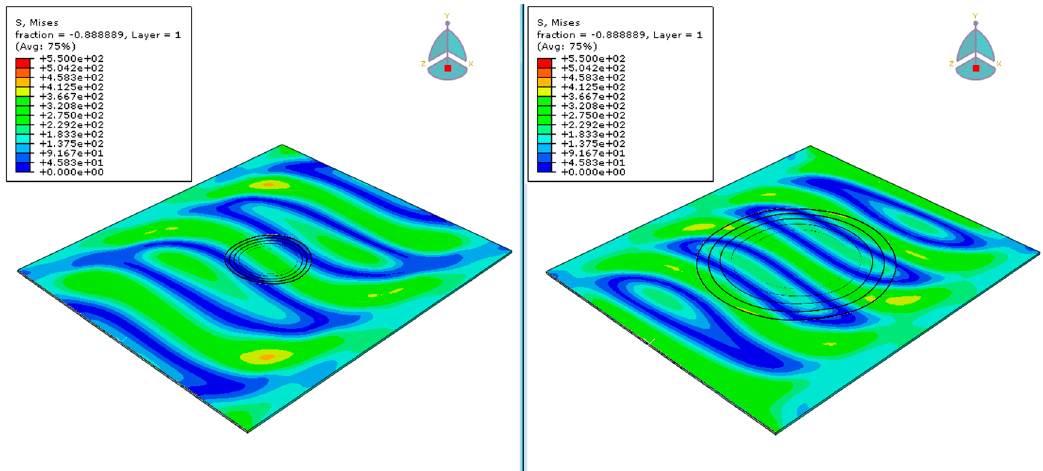
Figure 8. Distribution trends-based criterion Von Mises for repair with 20 ( left ) and 50 ( right ) ratio.